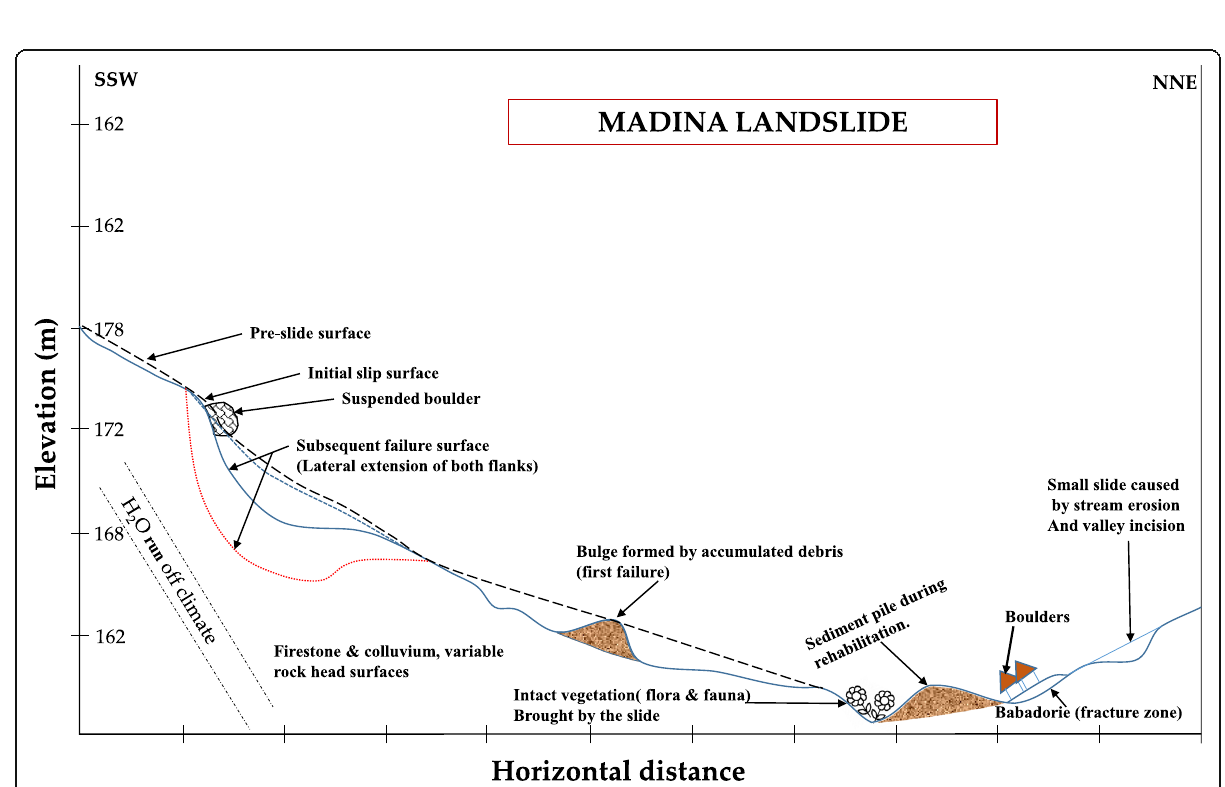
Fig. 13 The morphology and geology of Madina